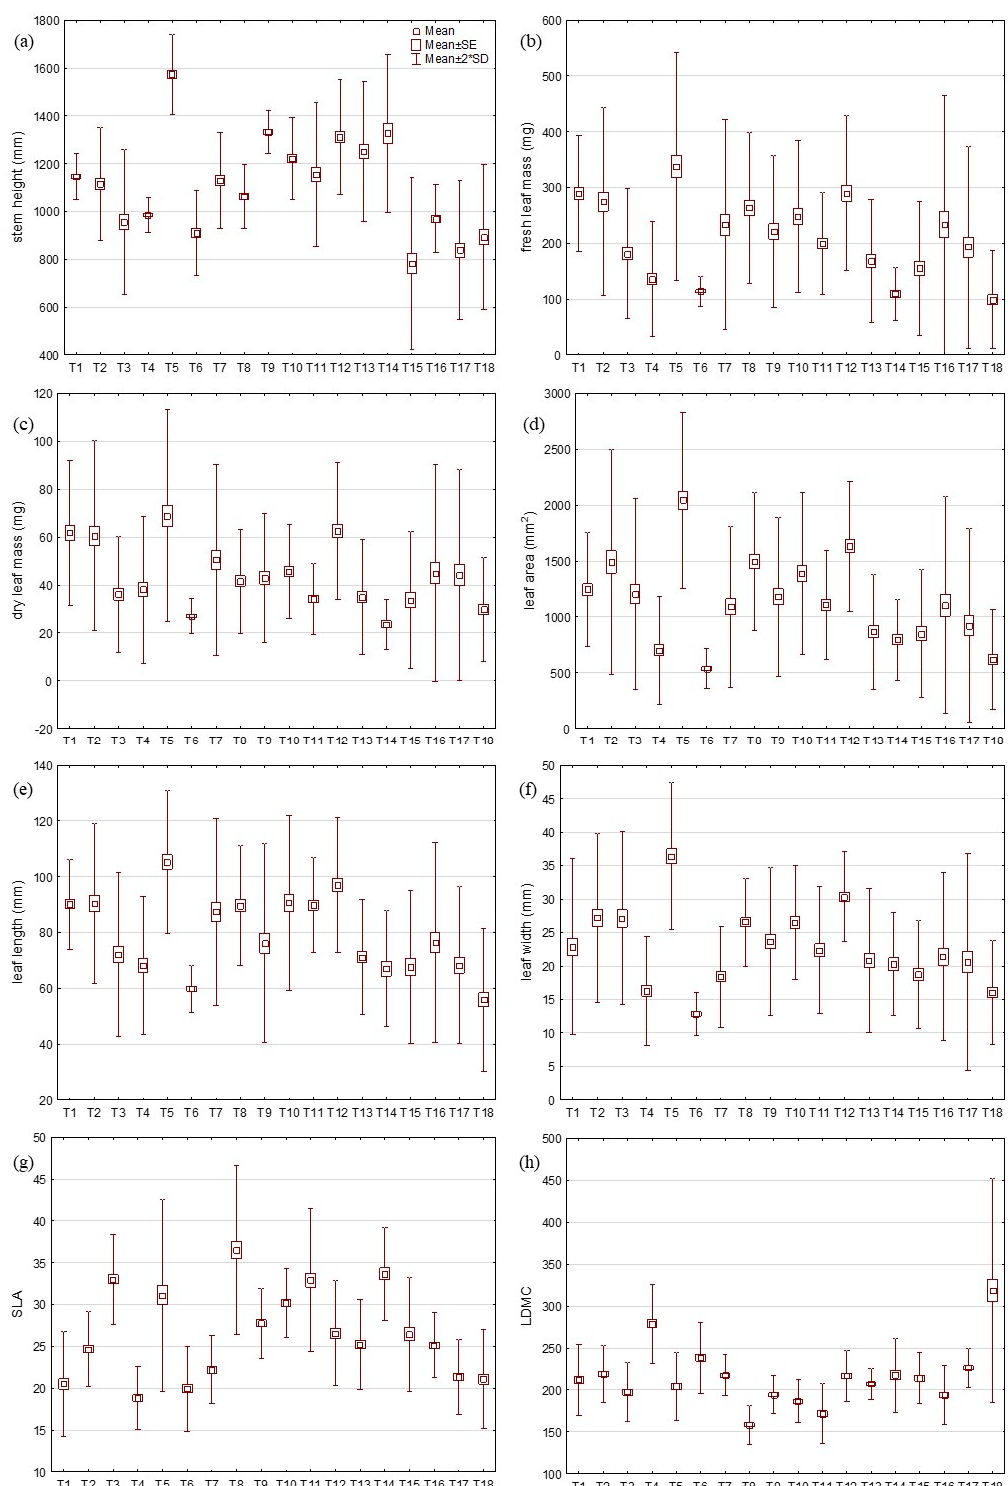
Figure 2. Plots of life trait mean values for populations of E. annuus distributed throughout 18 localities (T1-T18) showing standard error (SE) and standard deviation (SD). Presented life traits are ( a ) stem height, ( b ) fresh leaf mass, ( c ) dry leaf mass, ( d ) leaf area, ( e ) leaf length, ( f ) leaf width, ( g ) specific leaf area (SLA), ( h ) leaf dry matter content (LDMC).